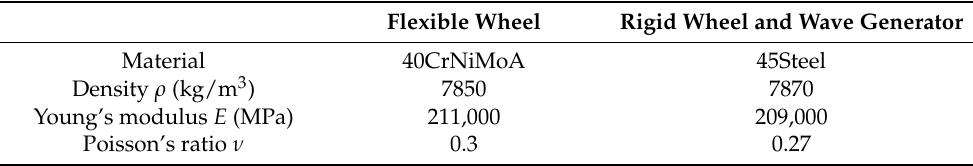
Table 2. Parameters of the flexible wheel, rigid wheel, and wave